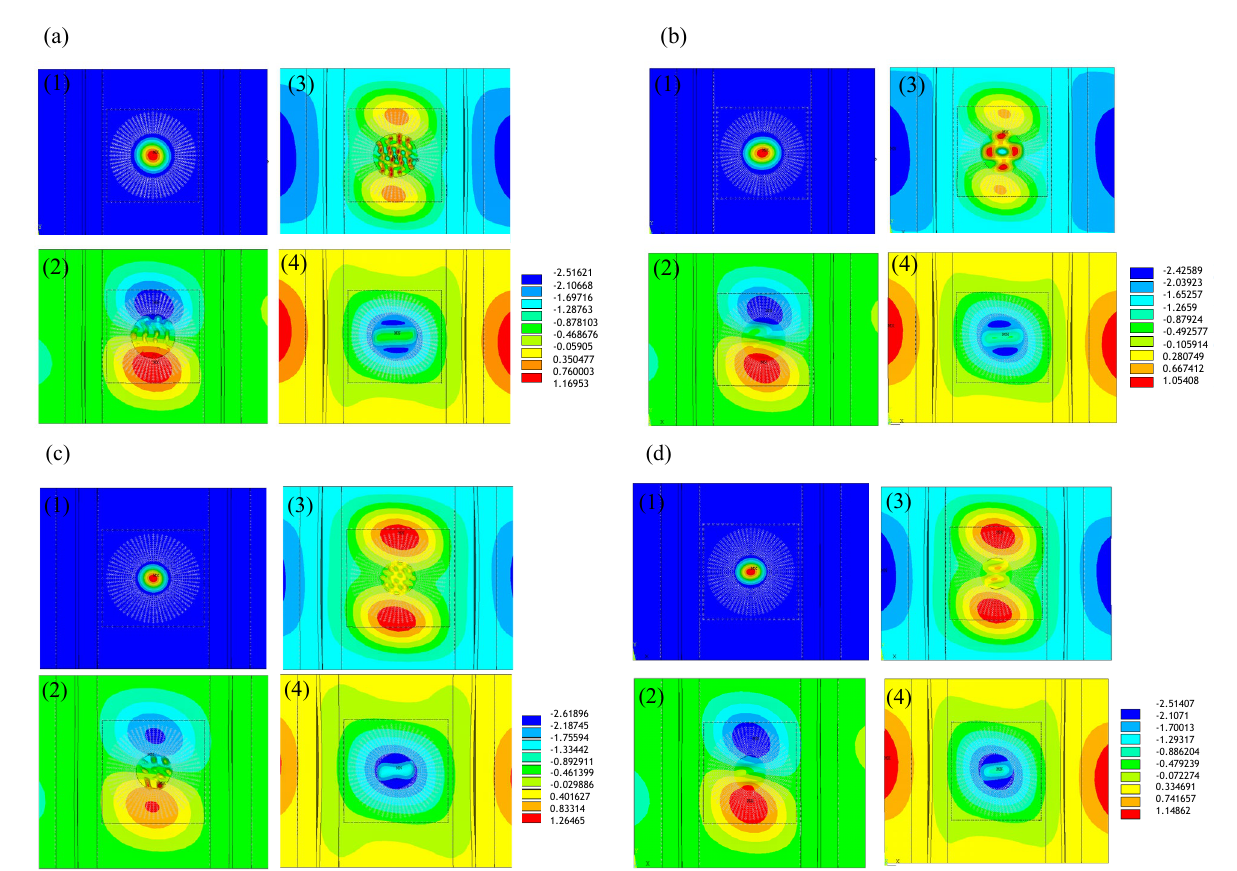
Figure 5. Out -of-plane displacement contour plot: ( 1) buckling of circular delamination, ( 2) buckling Figure 5. Out-of-plane displacement contour plot: (1) buckling of circular delamination, (2) buckling of the skin, ( 3) global buckling including stringers and ( 4) delamination initiation, with ( a ) CD1, ( b ) of the skin, (3) global buckling including stringers and (4) delamination initiation, with ( a ) CD1, CD2, ( c ) CD3 and ( d ) CD4. ( b ) CD2, ( c ) CD3 and ( d ) CD4.